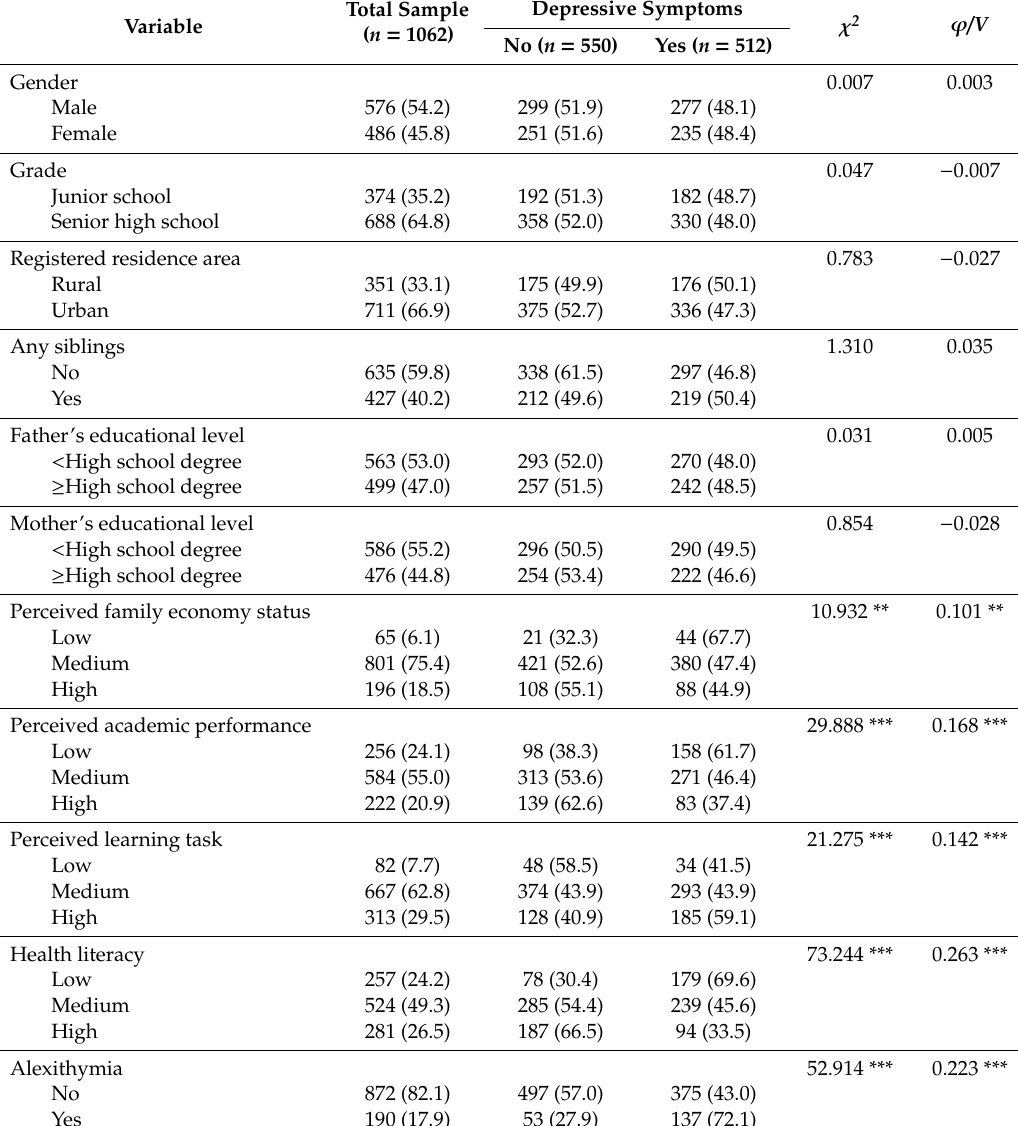
Table 1. Prevalence of depressive symptoms in the